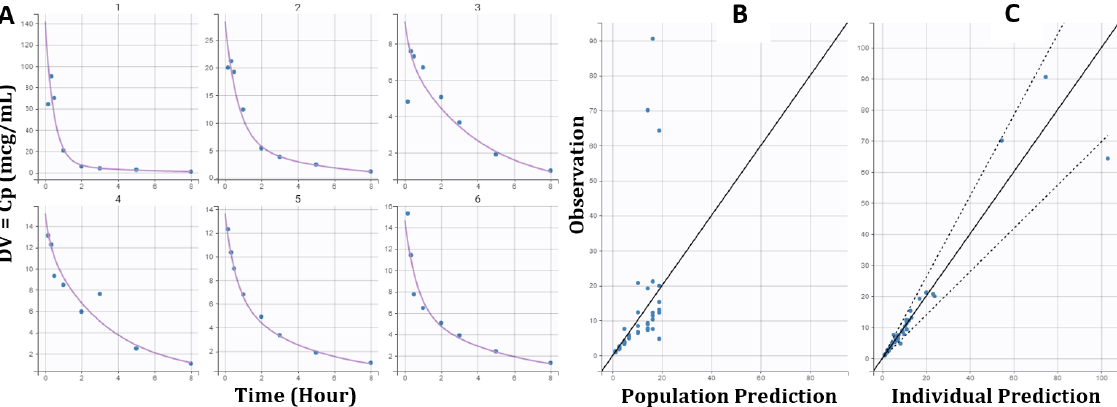
Figure 2. The goodness of fit of a two-compartment open model of levofloxacin after intravenous bolus injection, i.e., individual data fitting analyses (panel A); observation versus population prediction analysis (panel B) and observation versus individual prediction analysis (panel C), with a combination error model